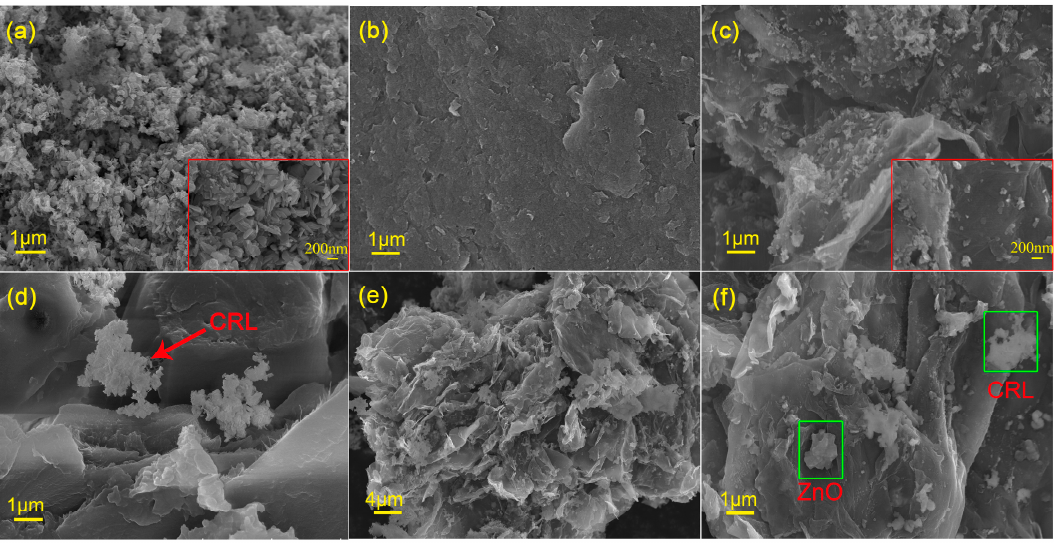
Figure 1. Scanning electron microcopy (SEM) images of ( a ) ZnO; ( b ) pristine GO; ( c ) GO/ZnO; ( d